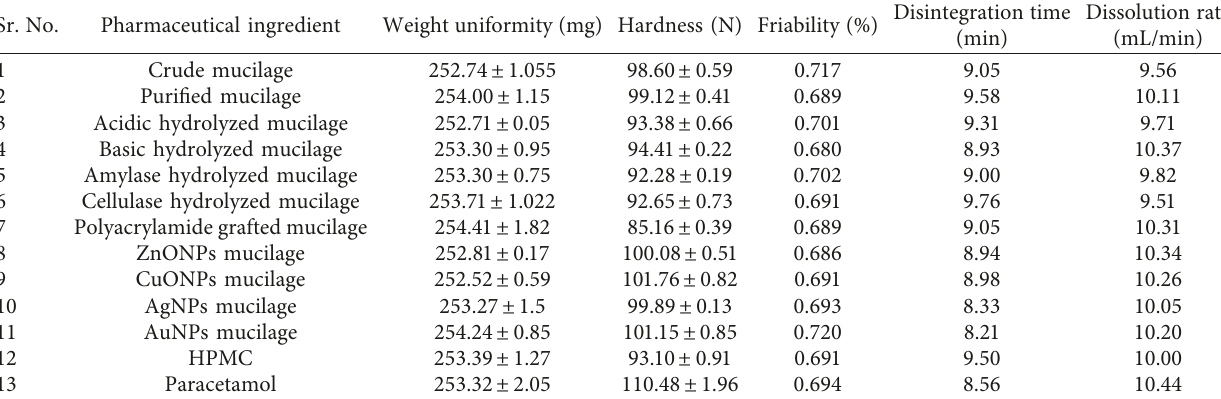
Table 3: Analysis of tablets prepared from different samples of date palm mucilages. Sr. No. Pharmaceutical